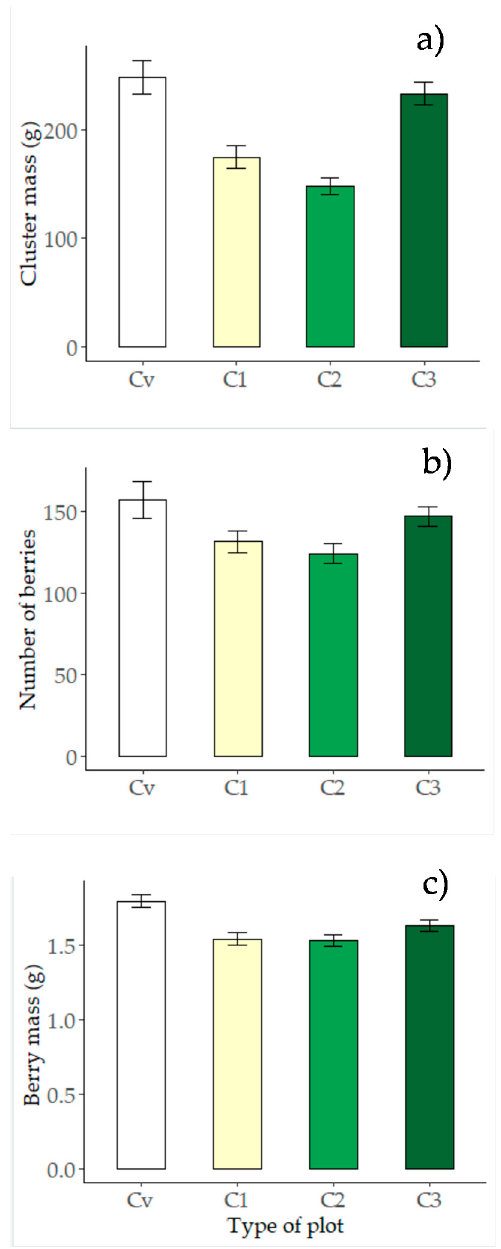
Figure 8. Yield components measured at harvest in conventional plots (Cv), and in plots in first (C1), second (C2) and third (C3) year of conversion to organic farming. ( a ) cluster mass, ( b ) number of berries per cluster and ( c ) berry mass. Mean ± standard deviation.